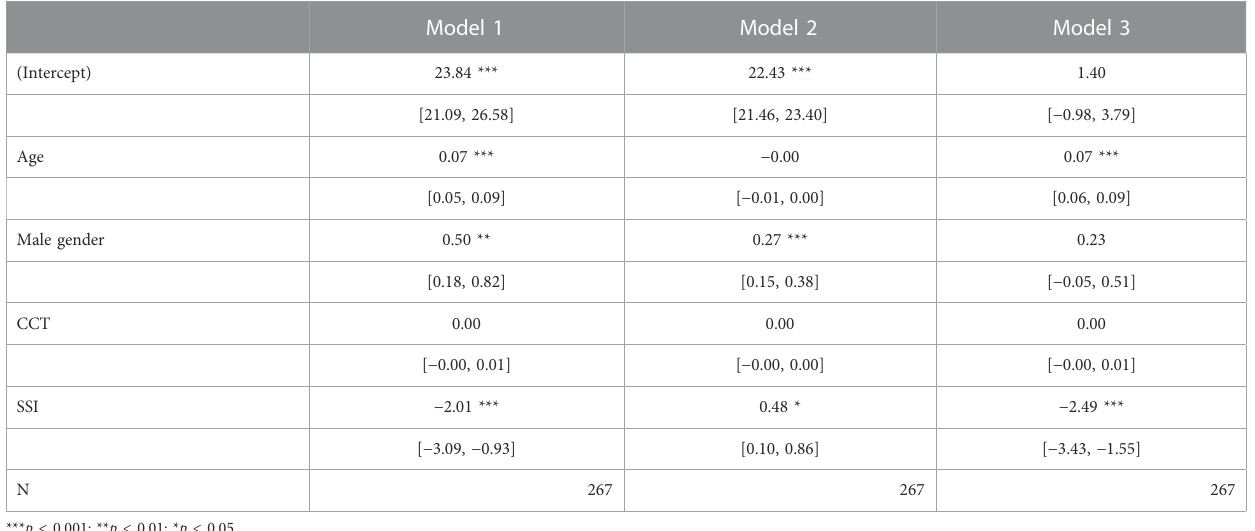
TABLE 2 Summary of linear regression models.